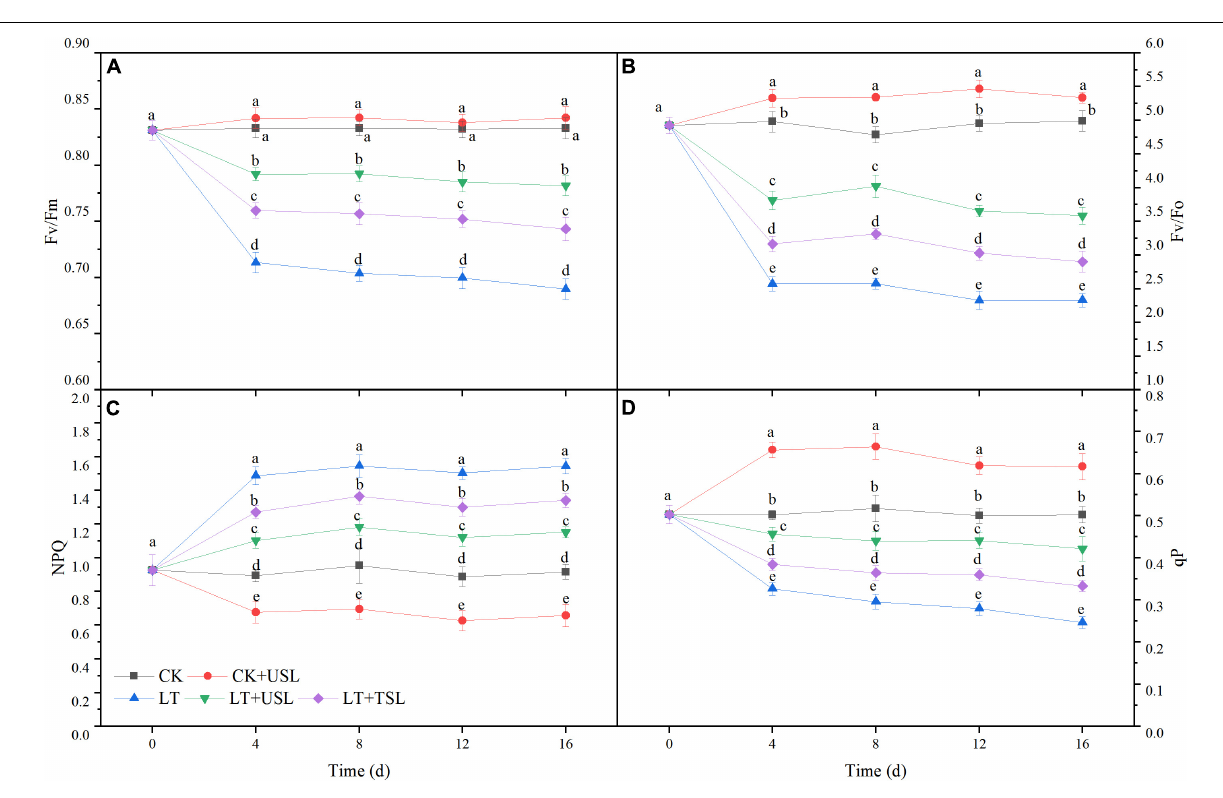
FIGURE 3 | Effects of USL on the PS II reaction center of tomato leaves under LT stress. (A) F v /F m , the maximal photochemical efficiency of PS II; (B) F v /F 0 , potential photochemical activity of PS II; (C) NPQ, light-induced non-photochemical quenching; and (D) qP, photochemical quenching